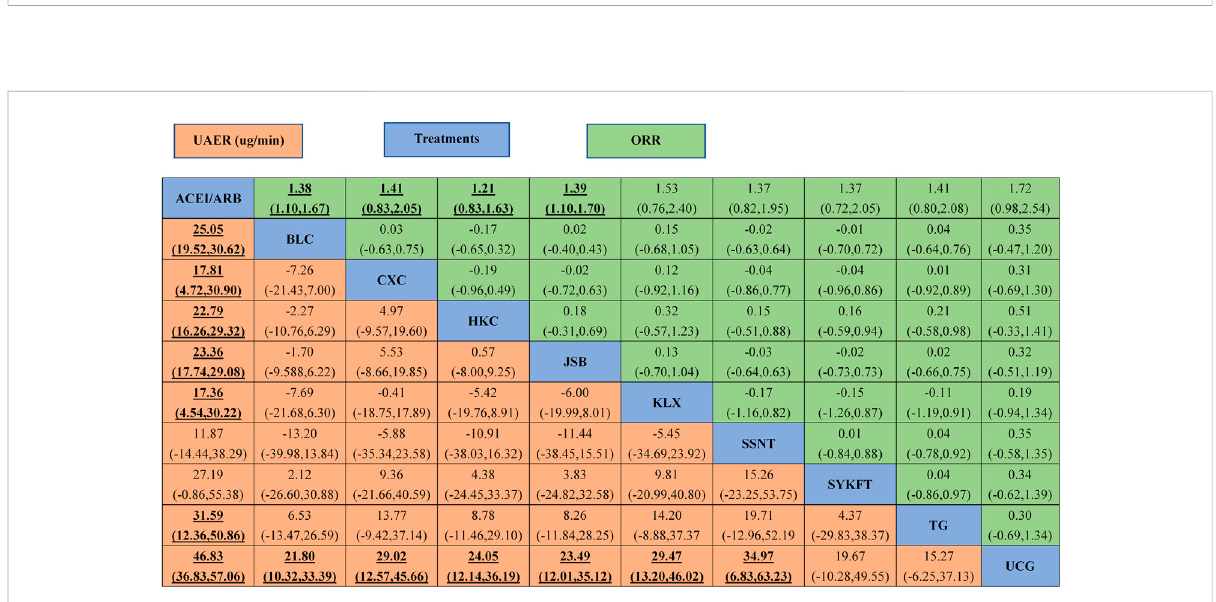
FIGURE 4 TheleaguetableofallcomparisonsofUAERandORR.DataareRRs(95%CI)forORR(upper-rightquadrant) andMDs(95%CI)forUAER(lower- left quadrant) in the column-de fi ning treatment compared with the row-de fi ning treatment. Signi fi cant results are in bold and underscored. BLC, Bailing capsule; JSB, Jinshuibao capsule; HKC, Huangkui capsule; UCG, uremic clearance granule; TG, tripterygium glycosides; CXC,